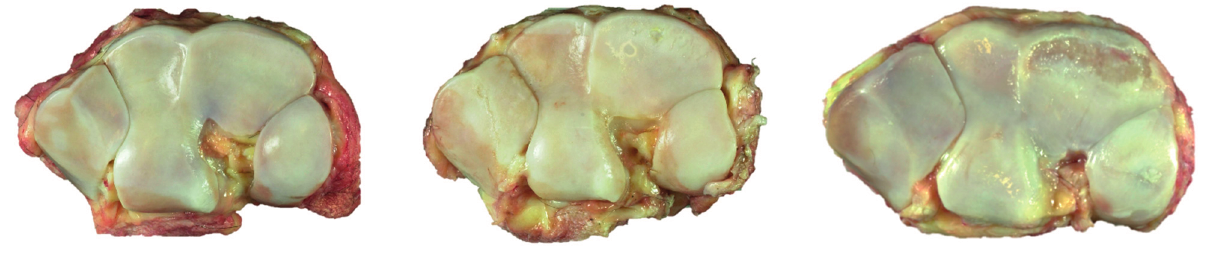
Figure 6. Third carpal bones, dorsal to top: Left , control; Center , early OA; and Right , advanced OA.